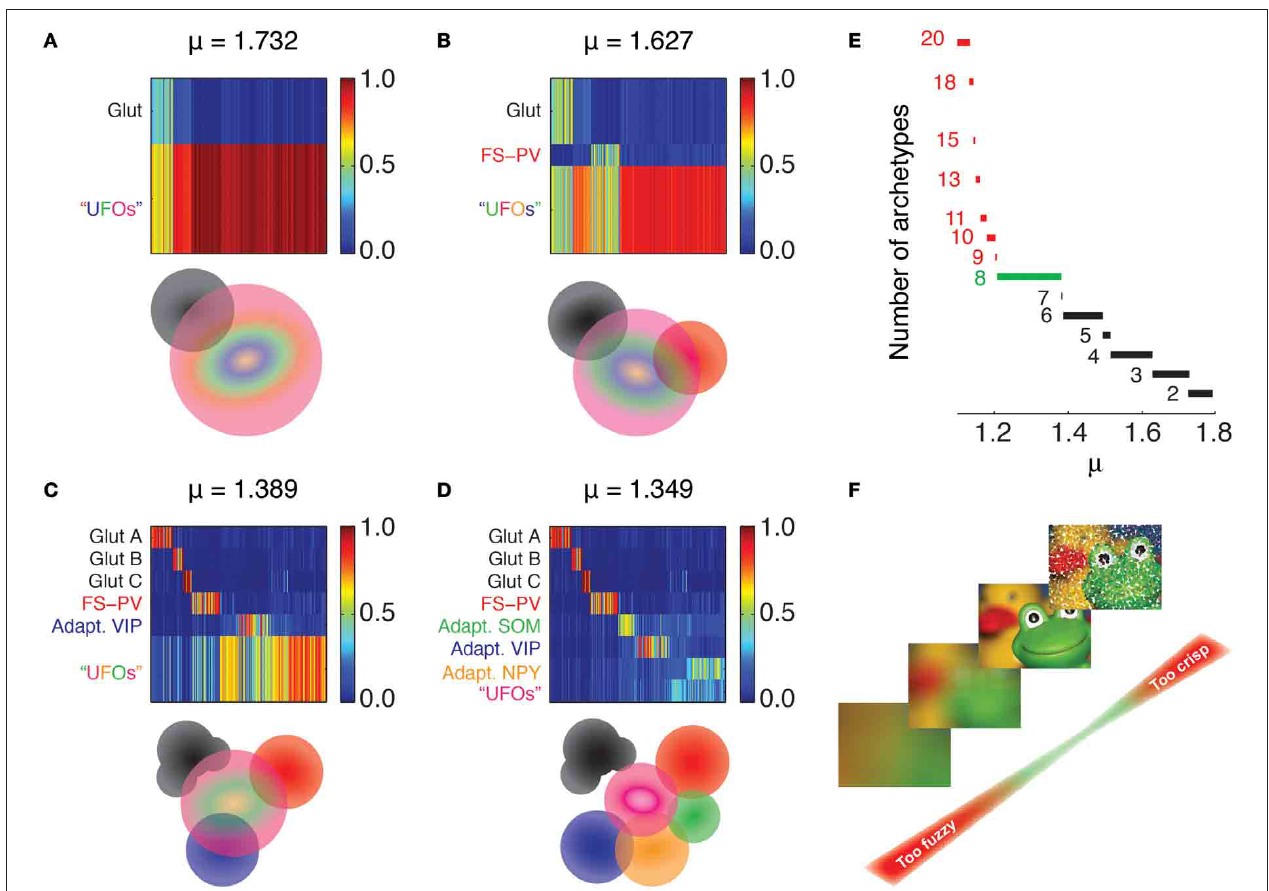
FIGURE 2 | Emergence of archetypes. Fuzzy partitions with decreasing μ values are visualized as membership matrices ( A–D , upper panels). Rows correspond to different fuzzy clusters and columns to individual neurons. Membership values of single neurons to each classare color coded (right bars). Schematic representation of the interrelations between archetypes (lower panels). Colored discs depict different archetypes and their overlaps denote cells with shared memberships. The Glutamatergic archetype is the first to emerge (black, A ), followed by FS-PV interneurons (Red, B ), and Adapting VIP interneurons (blue, C ). Note that the glutamatergic archetype splits into three sub-groups. Adapting SOM (green) and Adapting NPY (orange) archetypes and a residual UFO archetype of highly atypical inhibitory interneurons are the last